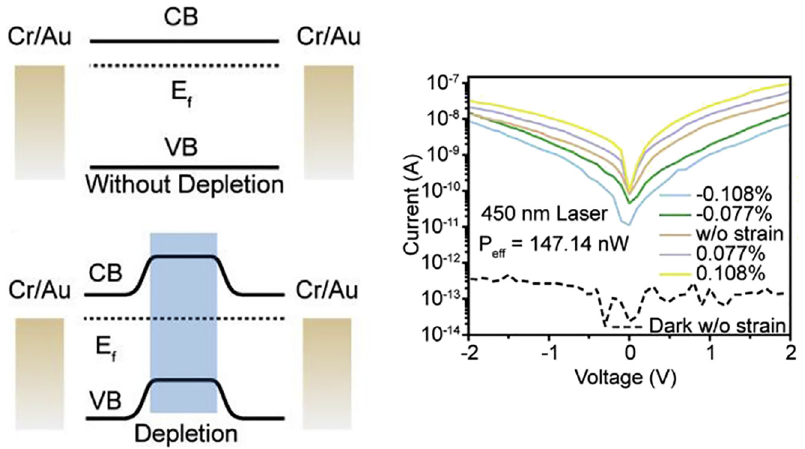
Figure 4: Integration of semiconductor NW and 2D materials for high-performance photodetectors. Left, the band structure of the WS 2 channel for pristine WS 2 photodetectors (upper part) and WS 2 /CsPbBr 3 vdWH photodetectors (lower part), respectively. Right, I – V curves of the WS 2 /CsPbBr 3 photodetectors under different